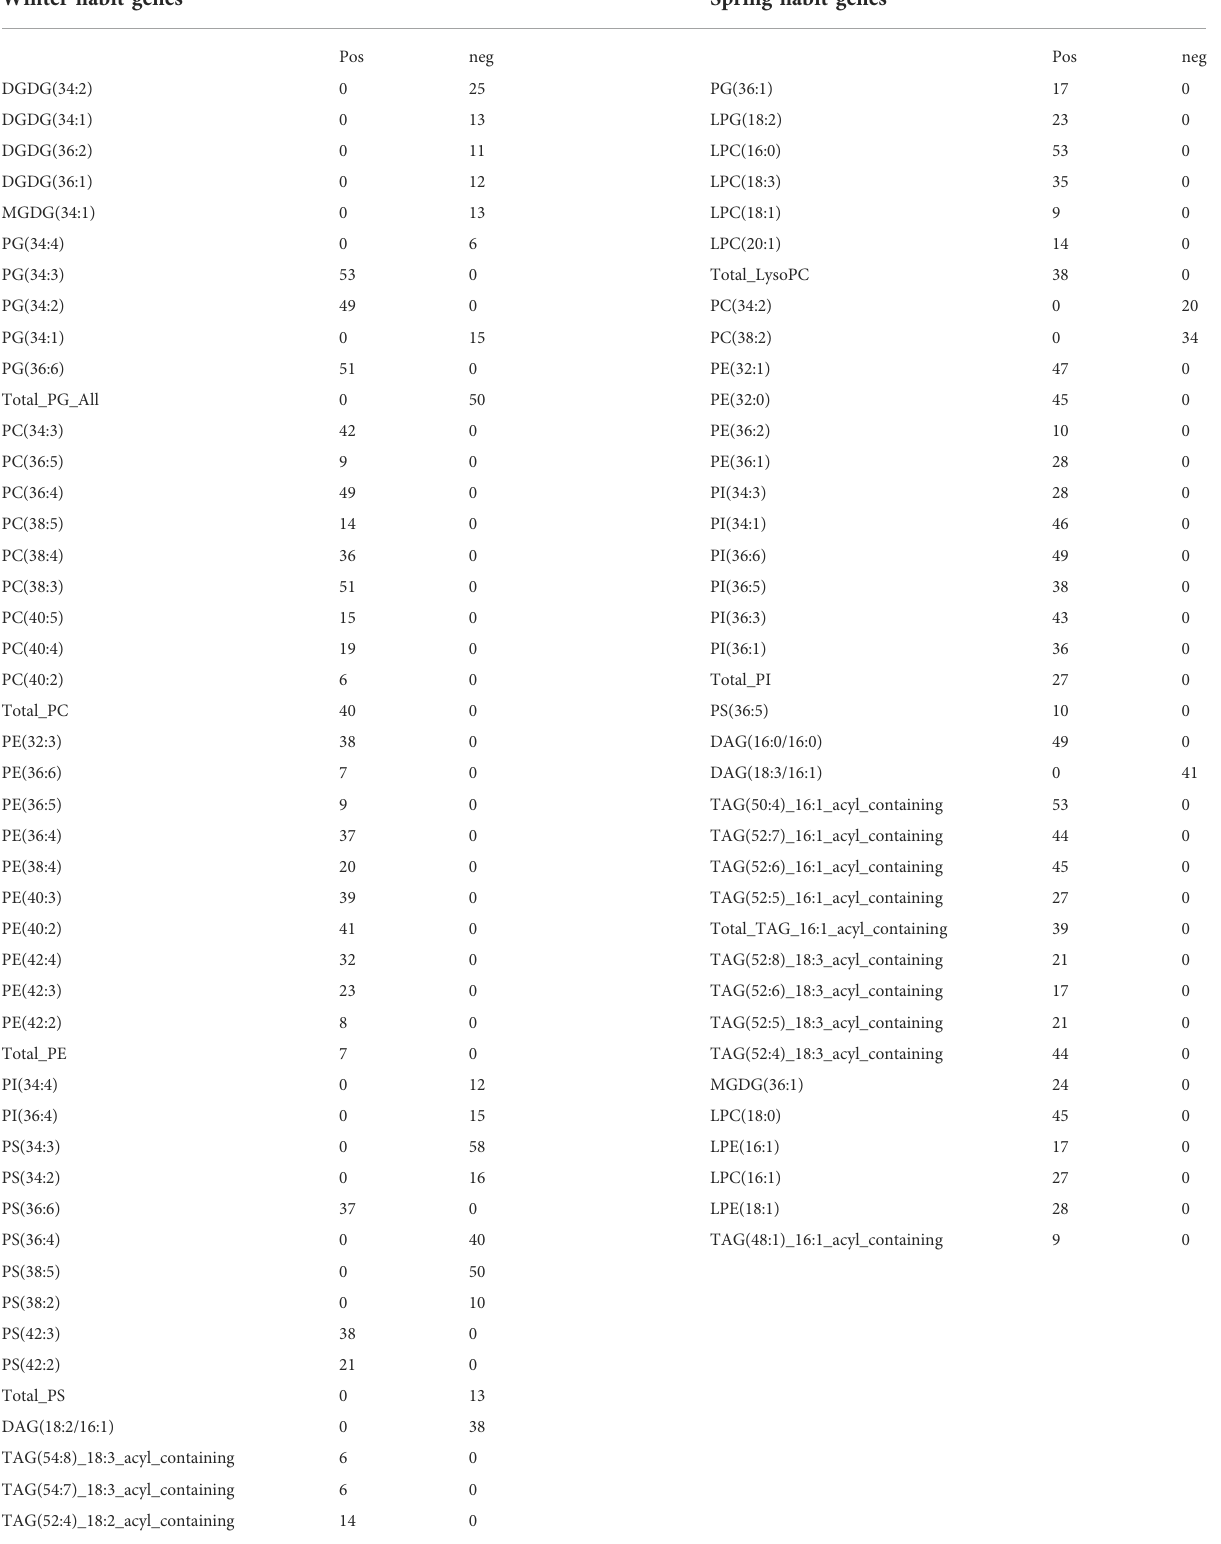
TABLE 5 Number of winter-habit genes (left a ) or spring-habit genes (right) correlated with respective lipid species. Winter habit genes Spring habit